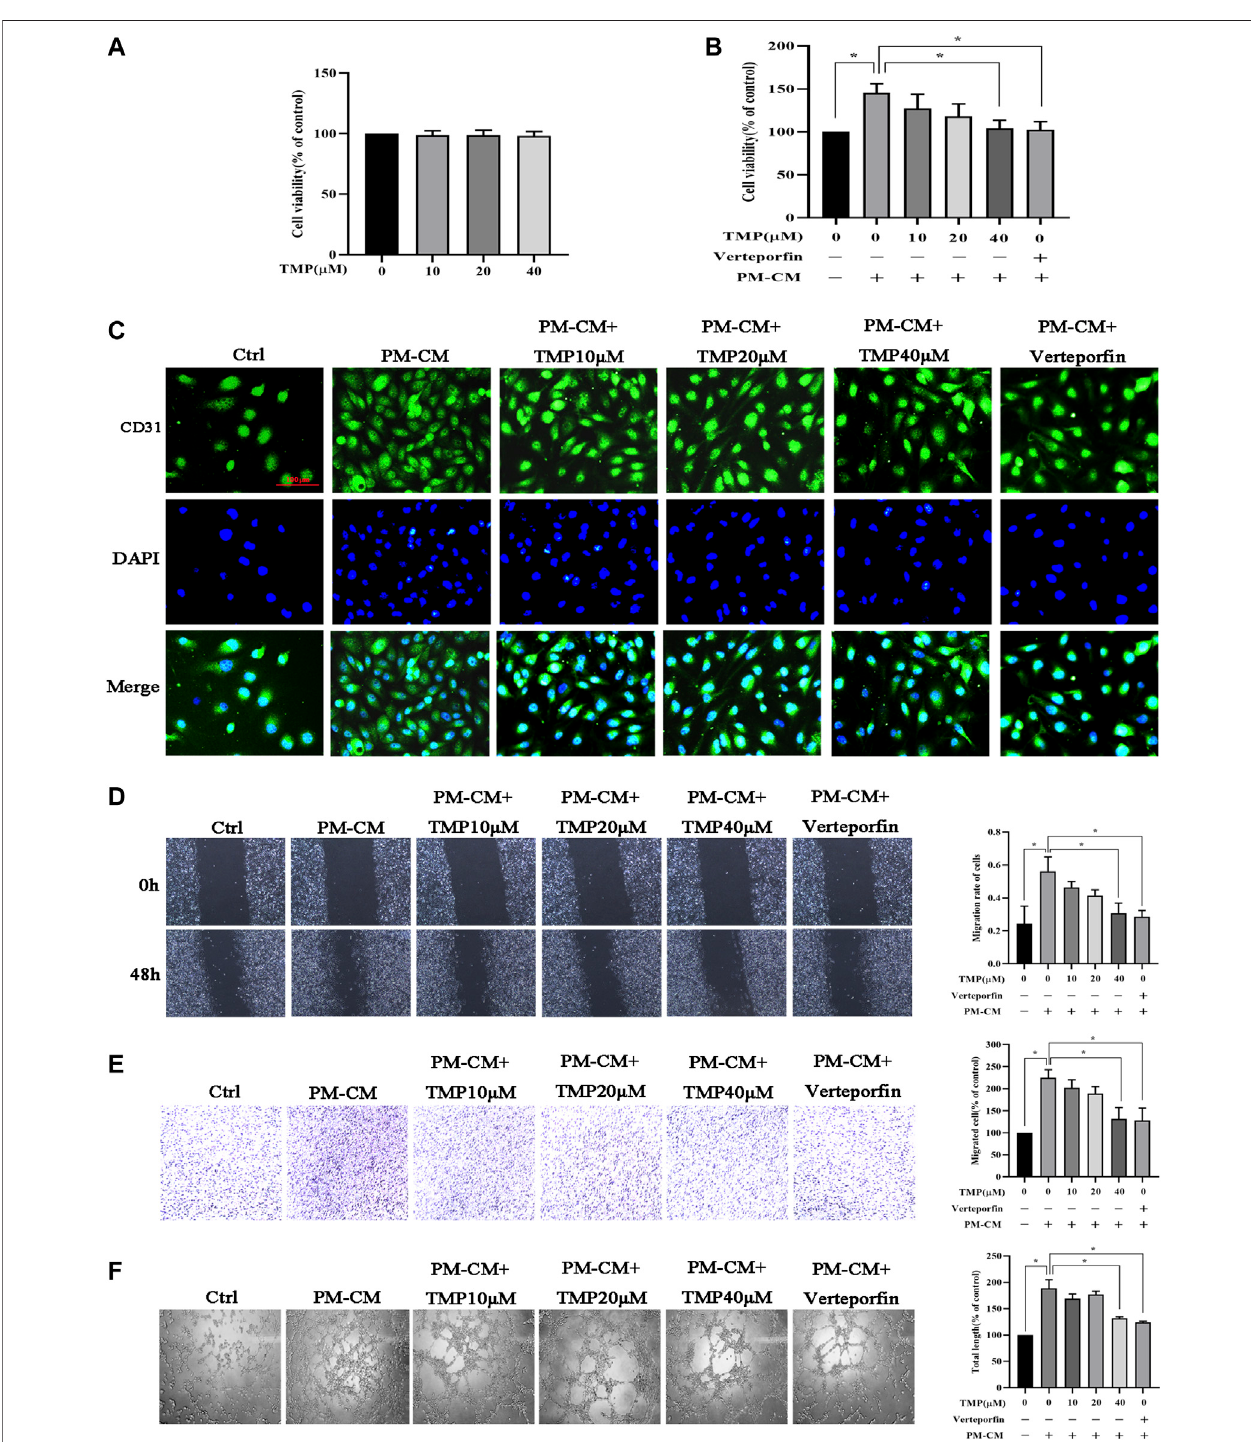
FIGURE 3 | Effect of TMP on peritoneal angiogenesis in vitro . (A) HPVECs were treated with serial concentrations of TMP (0, 10, 20, and 40 μ M) for 24 h. Neither strengthened cell proliferation nor apoptosis was observed. (B – F) HPVECs were exposed to PM-CM with or without various concentrations of TMP (0, 10, 20, and 40 μ M) and 60 nM vertepor fi n. Cell proliferation was detected by CCK-8 assay (B) and immuno fl uorescence assay for visualizing endothelial cells marker (scale bar (cid:2) 100 μ m) (C) . Migration of HPVECs was detected by wound healing assay (D) and transwellmigration assay (E) . (F) Tube formation was quanti fi ed by counting the total length in three randomly selected fi elds of view. Data represent mean ± SEM of at least 3 independent experiments (* p < 0.05).